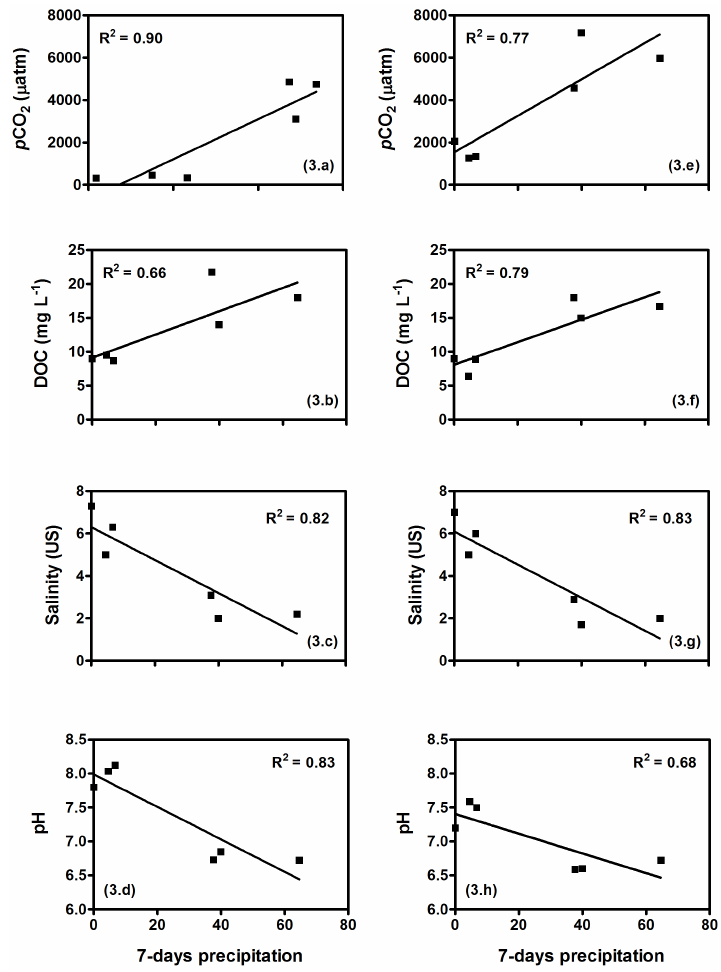
Fig. 3. The relationships between mean p CO 2 , DOC, salinity and pH with accumulated precipitation in the week preceding the sampling in the macrophyte covered (Figs. 3a, b, c, d) and open water (Figs. 3e, f, g and h) stations at Lake Carapebus. Solid lines represent significant linear regressions ( p < 0 .